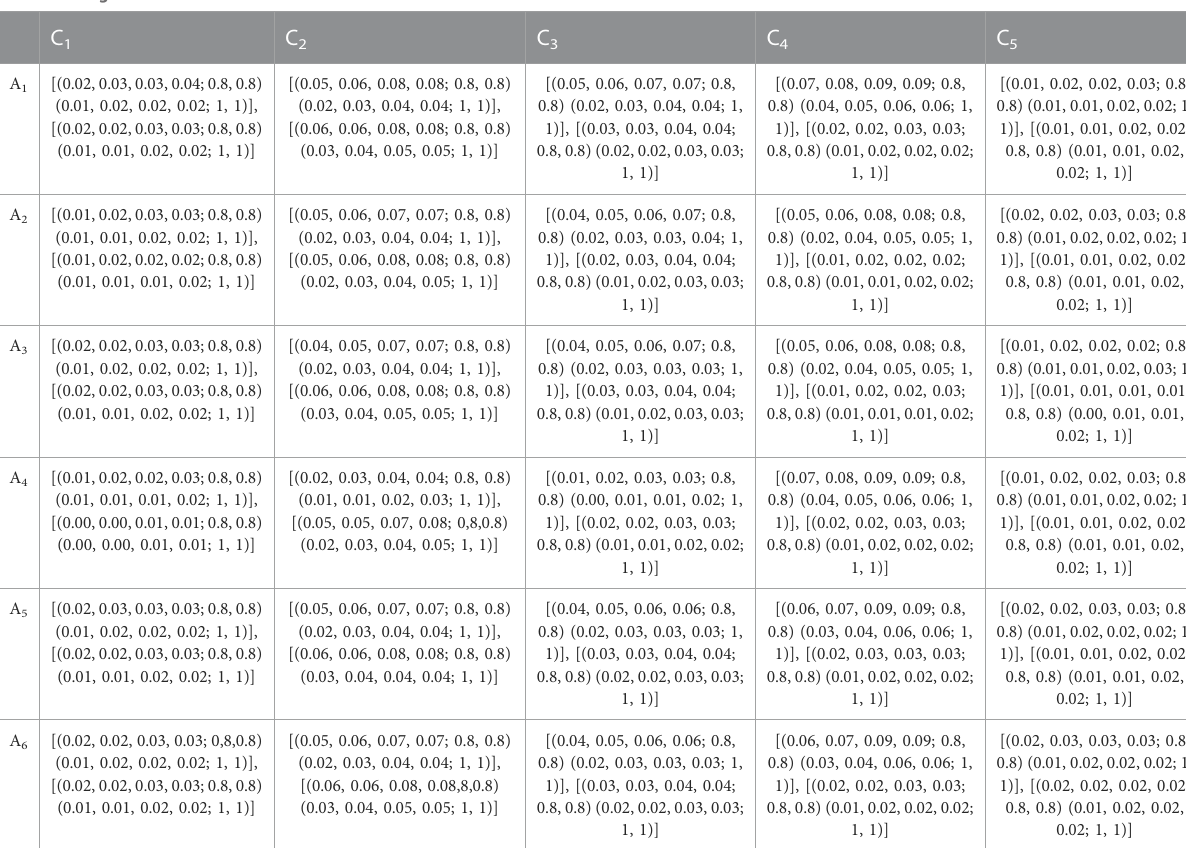
TABLE 6 Weighted decision